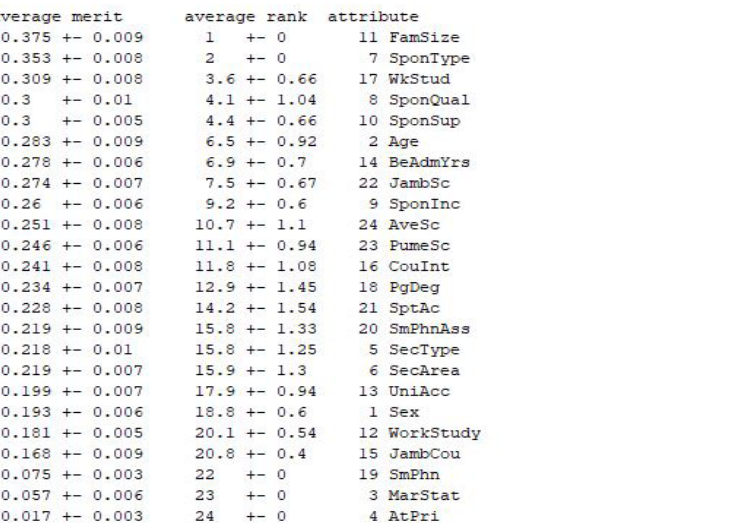
Figure 15: Results from ReliefF feature selection